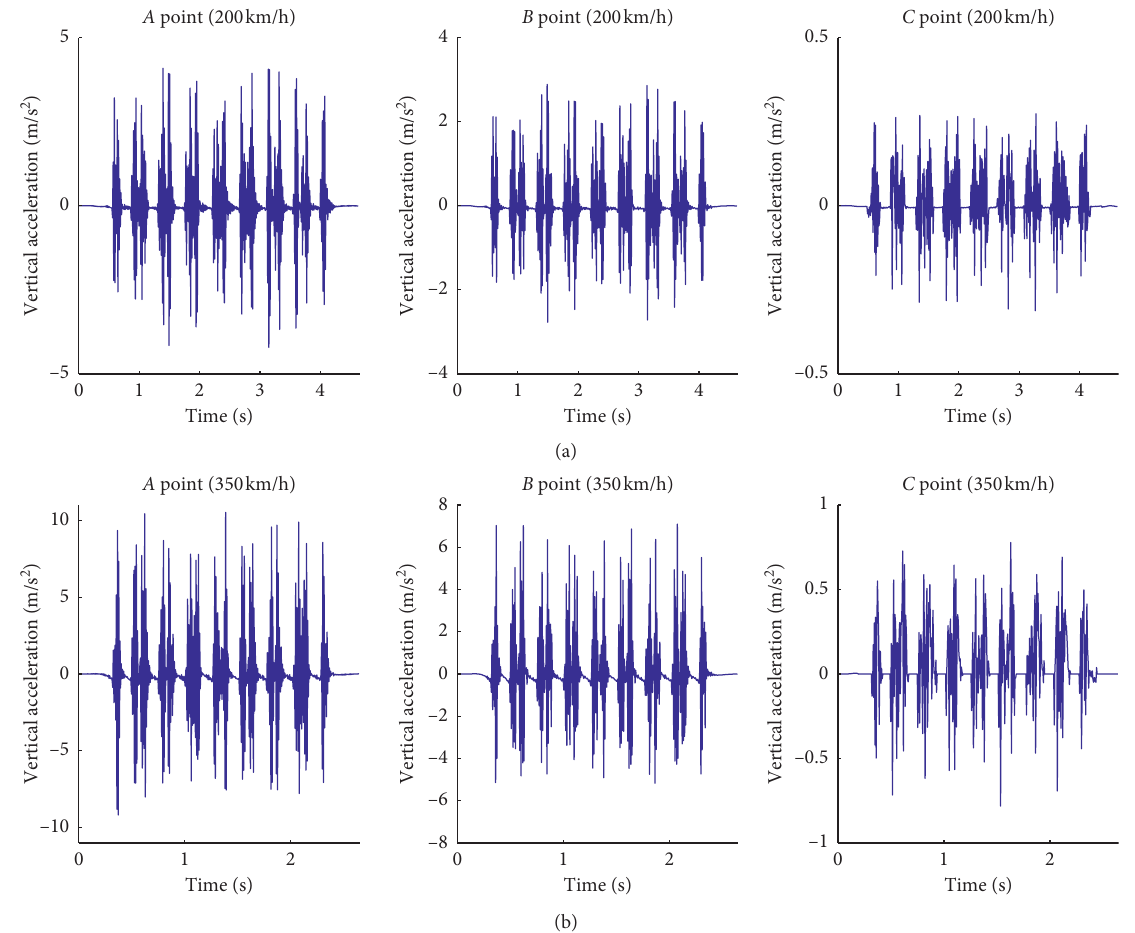
Figure 7: The simulated vertical accelerations at the points A, B, and C with the train speed 200 and 350km · h − 1